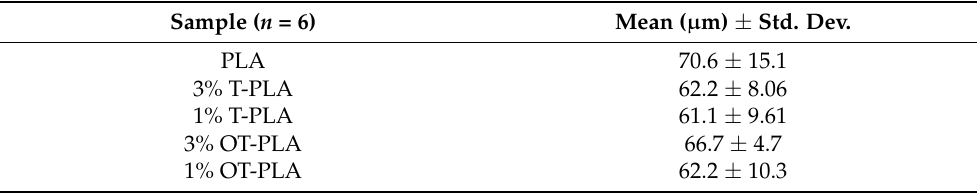
Table 1. Thickness (mean ± standard deviation) of Polylactic Acid (PLA), 3% TiO 2 PLA nanocompos- ite films (T-PLA), 1% T-PLA, 3% oleic-acid-modified OA_TiO 2 PLA nanocomposite films (OT-PLA) and 1% OT-PLA nanocomposite films covered the glass bottles ( n =